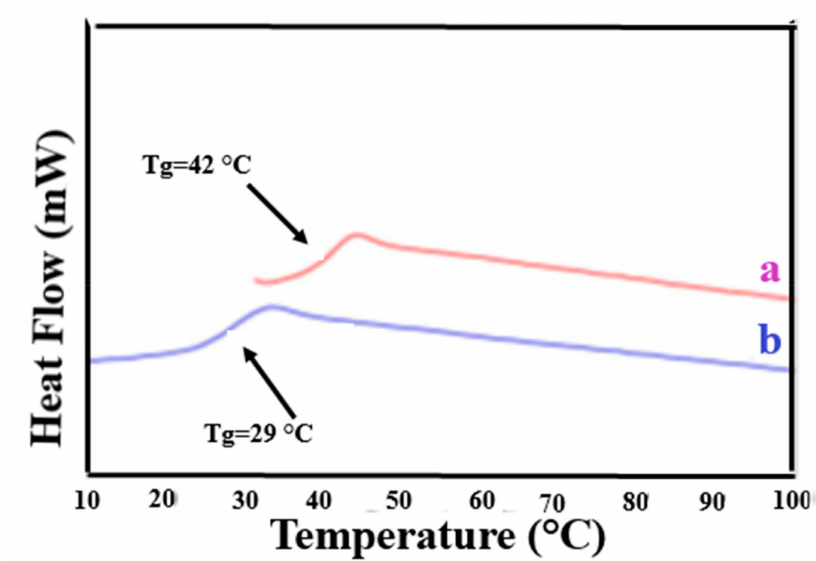
Figure 5. DSC thermograms of the second heating scan of: ( a ) c-PVAc from its γ -CD–IC; and ( b ) asr-PVAc. Reproduced with permission from the publisher [24]. Copyright 2005 Elsevier Ltd.